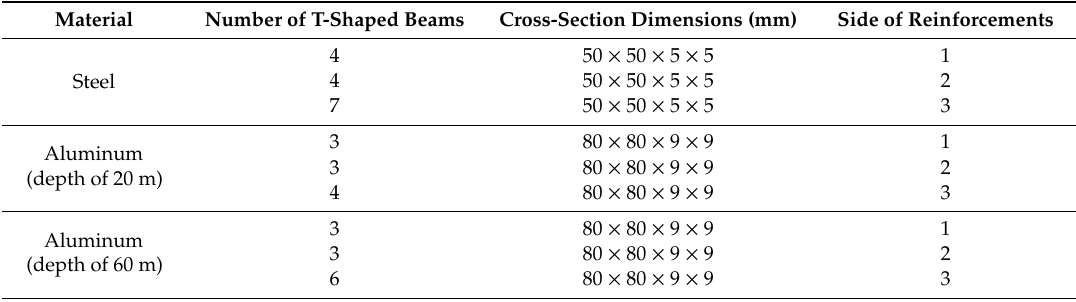
Table 2. Geometrical and mechanical properties of the rectangular compartment